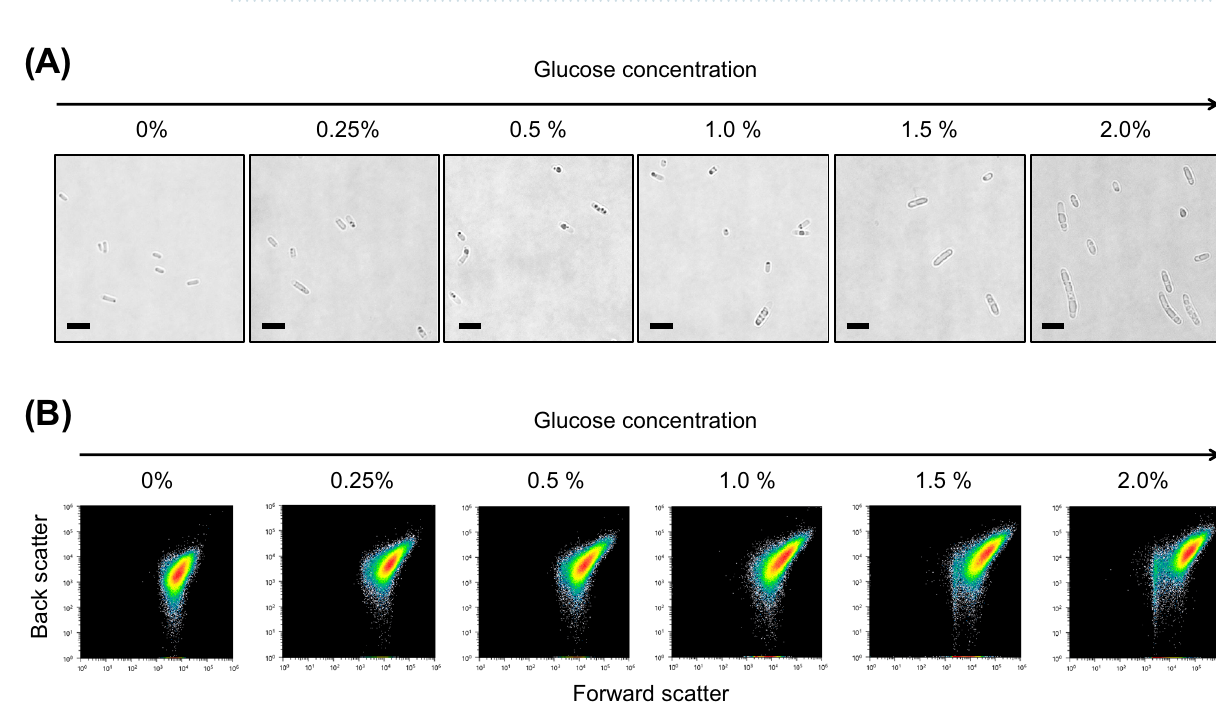
Figure 6. Morphological change of the BW/PHB (+) cells by varying glucose concentration. Cells were cultivated under five different glucose concentrations (0% to 2.0%) at 30 °C for 48 h cultivation. ( A ) Microscopic images of the BW/PHB(+) cells. Scale bars, 5 μm. ( B ) Flow cytometry to determine change in cell size. The intensity of forward scatter signals and back scatter signals are related to cell size and granularity,